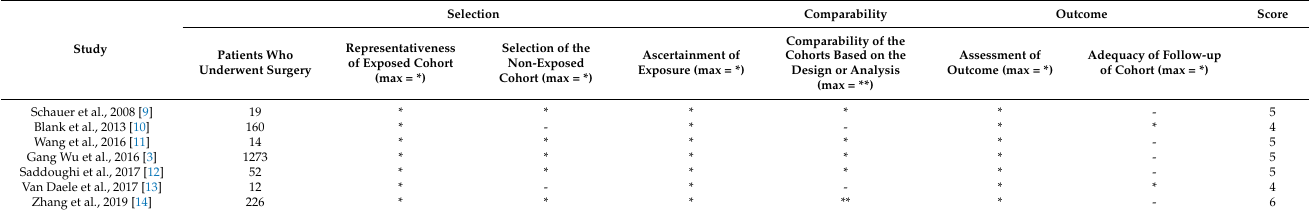
Table 2. Quality assessment of the selected studies assessed by Newcastle–Ottawa scale